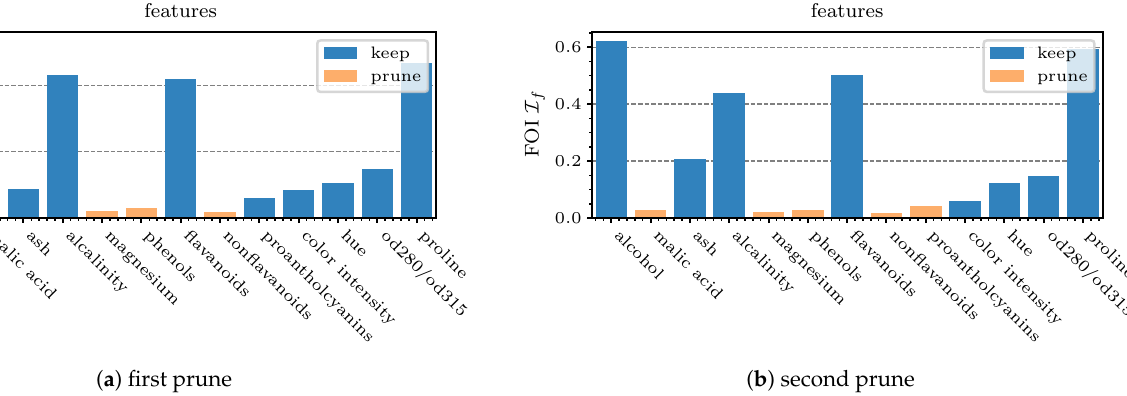
Figure 9. Feature selection callback histories of a single FeaSel-Net run on the Wine Classification dataset. The monitored accuracy ( a ) and the corresponding loss ( c ) are shown on the left. A character- istic sawtooth pattern can be observed. The threshold for the pruning is set to τ acc = 0.98 and the desired number of features is q = 3. An exponential pruning with a rate of π = 0.2 for the decrease in the number of features is chosen. An overview on the decreasing input information (i.e., pruning of features); ( b ) and the development of the masking layer ( d ) is given on the right. Chosen features can be retrieved from the dark blue bars in the masking history. Darker bars represent features that are pruned late in the recursive process and, thus, tend to hold more information.